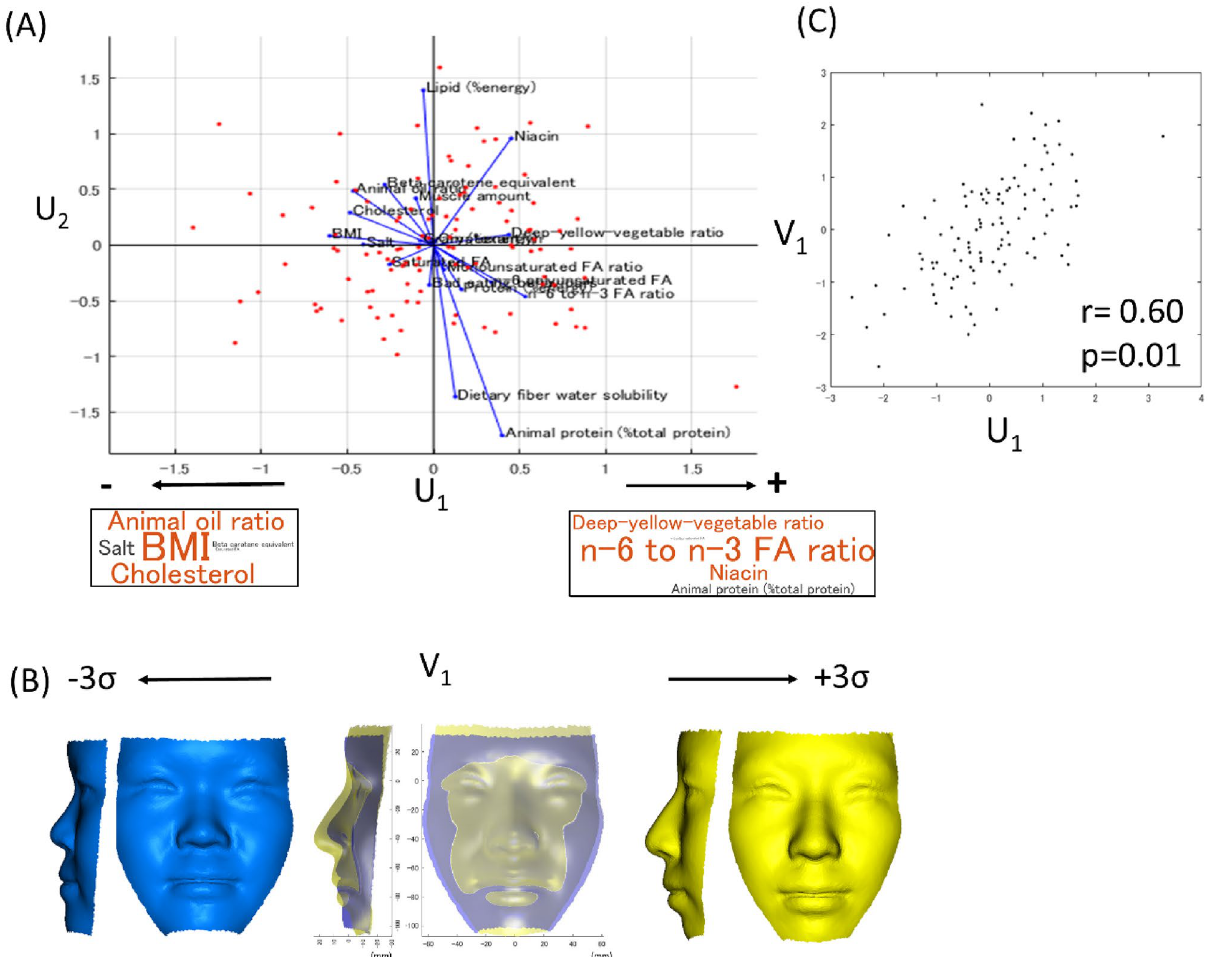
Figure 4. Result of a canonical variate (CV) analysis. A significant correlation was found in the first CV (CV 1, p < 0.01, r = 0.60). ( A ) Nutritional axes of CVs 1 and 2 (U 1 and U 2, respectively). U 1 was associated with a greater intake of n-6 polyunsaturated FA relative to n-3 unsaturated FA, deep-yellow-vegetable relative to the total vegetables, and niacin. In contrast, the negative direction of the U-axis was associated with a larger BMI and greater intake of dietary cholesterol, animal oil relative to total oil, and salt. ( B ) Visualization of the facial axis of CV1 (V 1 ). A CV analysis showed that V 1 was explained by shape principal components (sPCs) 1, 4, 5, and 7 with standard coefficients of − 0.67, + 0.34, − 0.56, and − 0.34, respectively. This means that the V-axis was associated with a smaller facial width, midfacial protrusion, posterior divergent face (sPCs 1, 4, and 7), lower position of the eyes (sPC4), smaller mandible height and retruded chin (sPC5), thick lips, and greater nasal width (sPC7). (C) A scatter plot of U 1 (nutrition) and V 1 (facial shape). A custom-made MATLAB based software (MATLAB 2021a, The MathWorks, Inc., Natick, MA) was used to create this